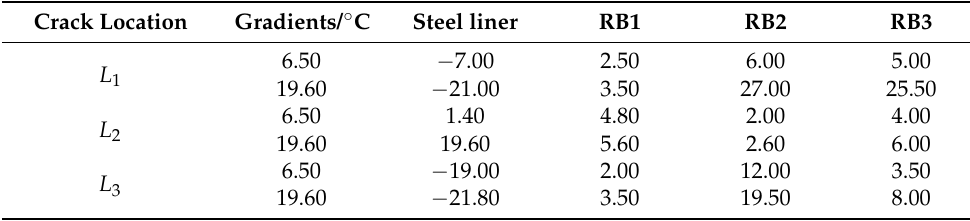
Table 5. Thermal steel stress around the crack exposed to temperature field C (unit: MPa). Crack